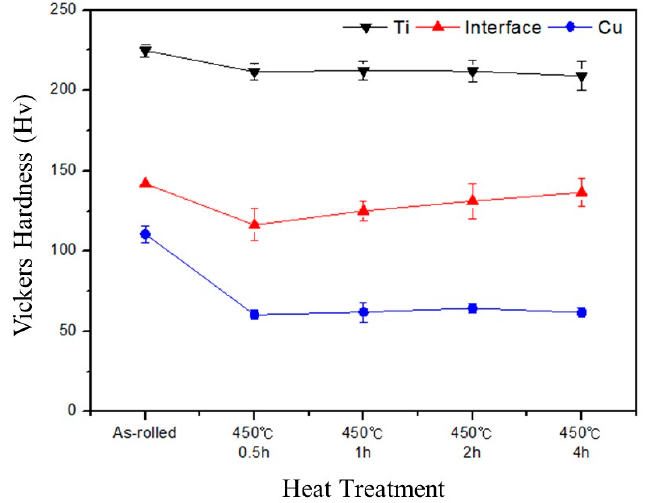
Figure 4. Vickers micro hardness of the component layers (Ti, Cu) and interface layers (Ti / Cu) for as-rolled and annealed clads.